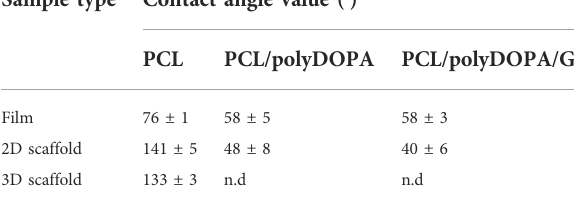
TABLE 1Contact anglevaluesofPCL-based fi lms,2Dand3Dscaffolds after each functionalization step. Sample